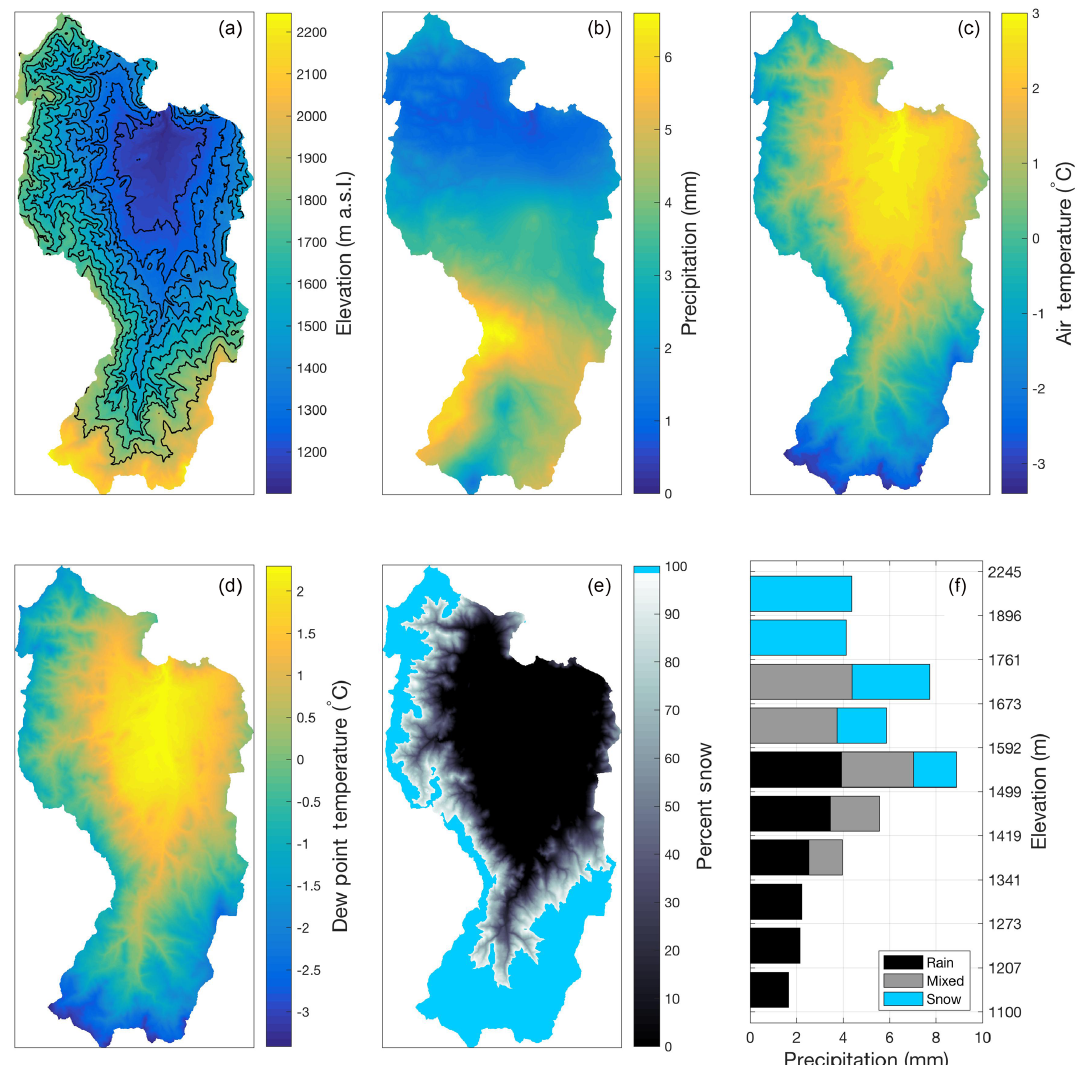
Figure 5. Example data from a mixed-phase precipitation event that occurred on 21 January 2002 at 13:00 mountain standard time show- ing (a) the digital elevation model with black lines showing the delineation of bands that precipitation phase was extracted for (f) , (b) the distributed precipitation amount, (c) the distributed air temperature, (d) the distributed dew point temperature, (e) the distributed precipita- tion phase, and (f) the amount and phase of precipitation that fell in each elevation band described in (a) . Air temperature and dew point temperature are very similar because this time period is during a precipitation